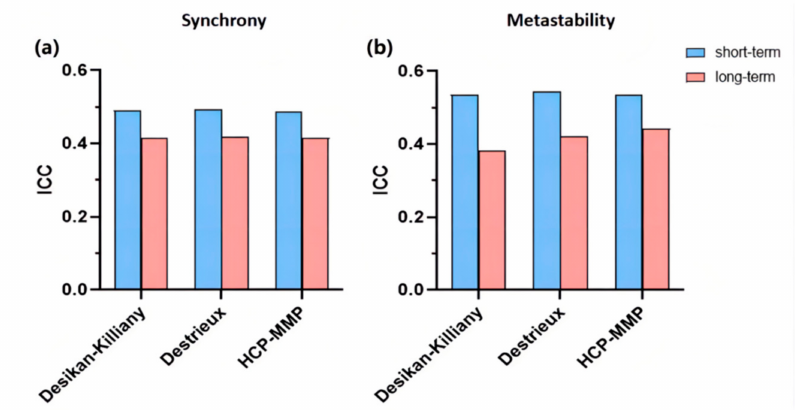
Figure 6. Reliabilities of synchrony ( a ) and metastability ( b ) in different node definition strategies, evaluated by the intraclass correlation coefficient (ICC). Blue bars represent short-term reliability and pink bars represent long-term reliability.